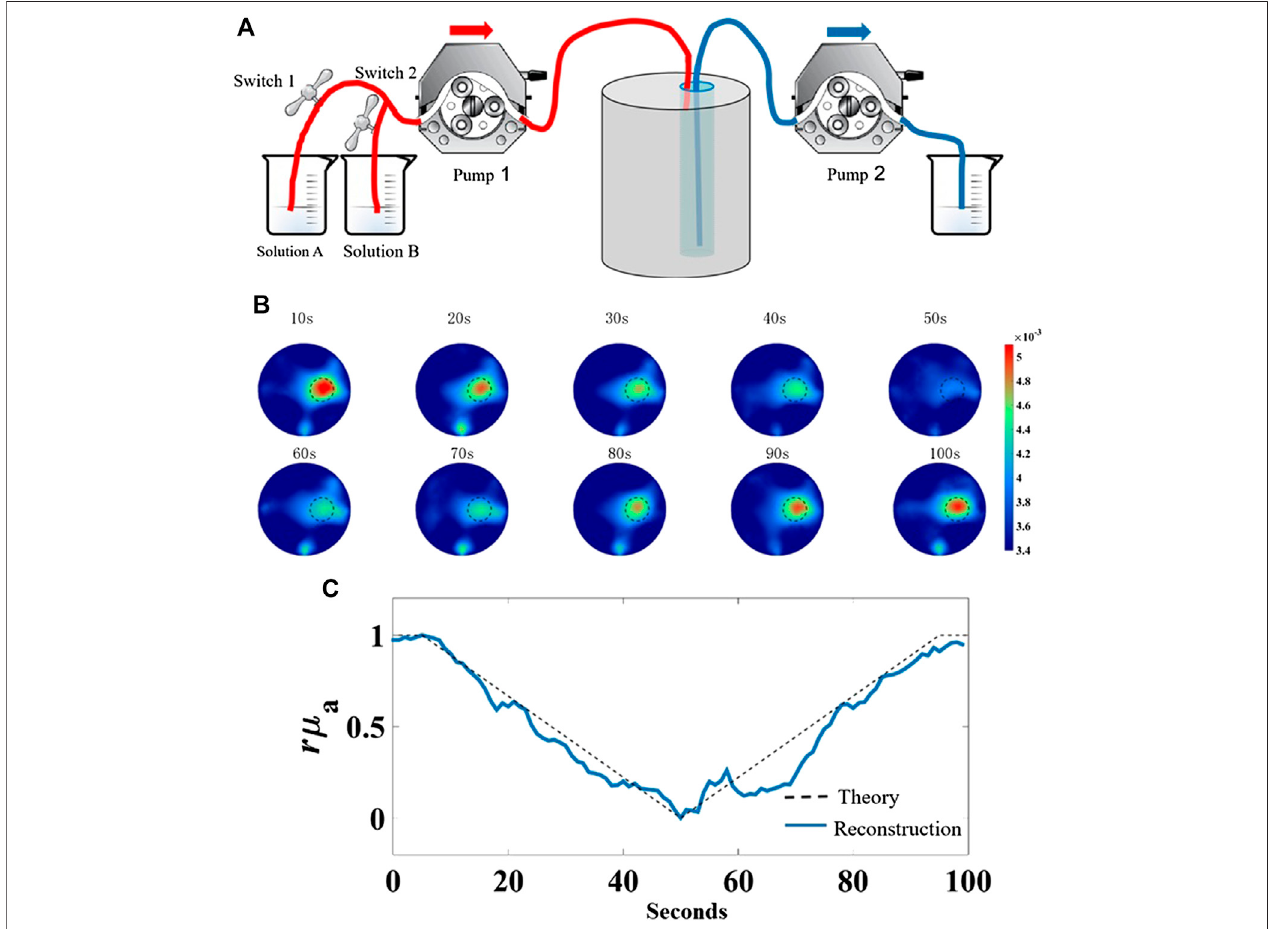
FIGURE 8 | Dynamic phantom experiment to mimic the process of breath hold. (A) Schematic of dynamic phantom, (B) representative 10 reconstructed absorption coef fi cient images in chronological order, (C) plots of the normalized theoretical values and average values of reconstructed absorption coef fi cient in the target region vs. measurement time.